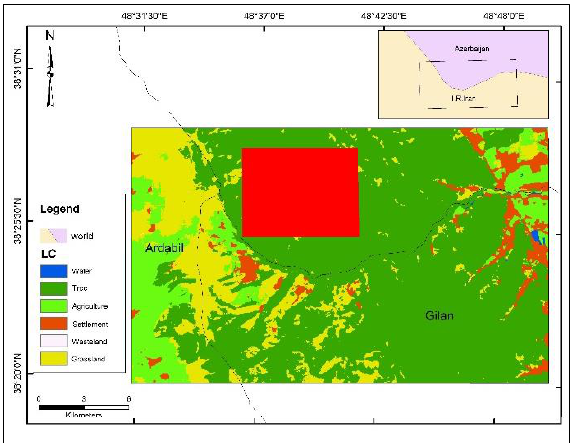
Figure 7. Control region for final modelling.